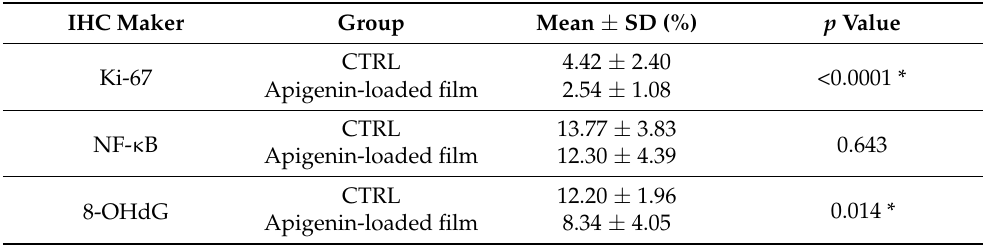
Table 5. The comparison of the percentage of positively stained areas. Data are given as